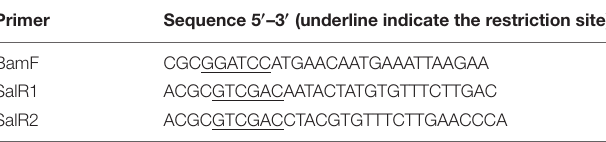
TABLE 2 | Primers used to amplify hepT